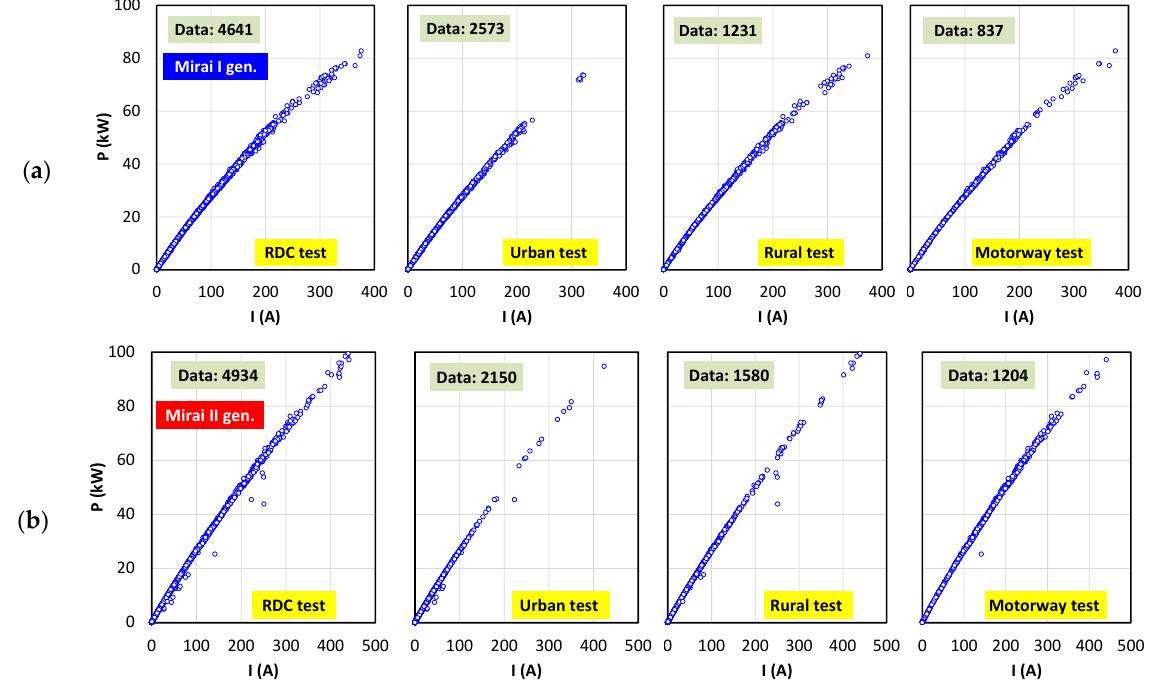
Figure 16. Characteristics of a fuel cell stack in relation to the current intensity of the fuel cell stack and the power of the fuel cell stack: ( a ) I generation FCHEV drive; ( b ) II generation FCHEV drive.